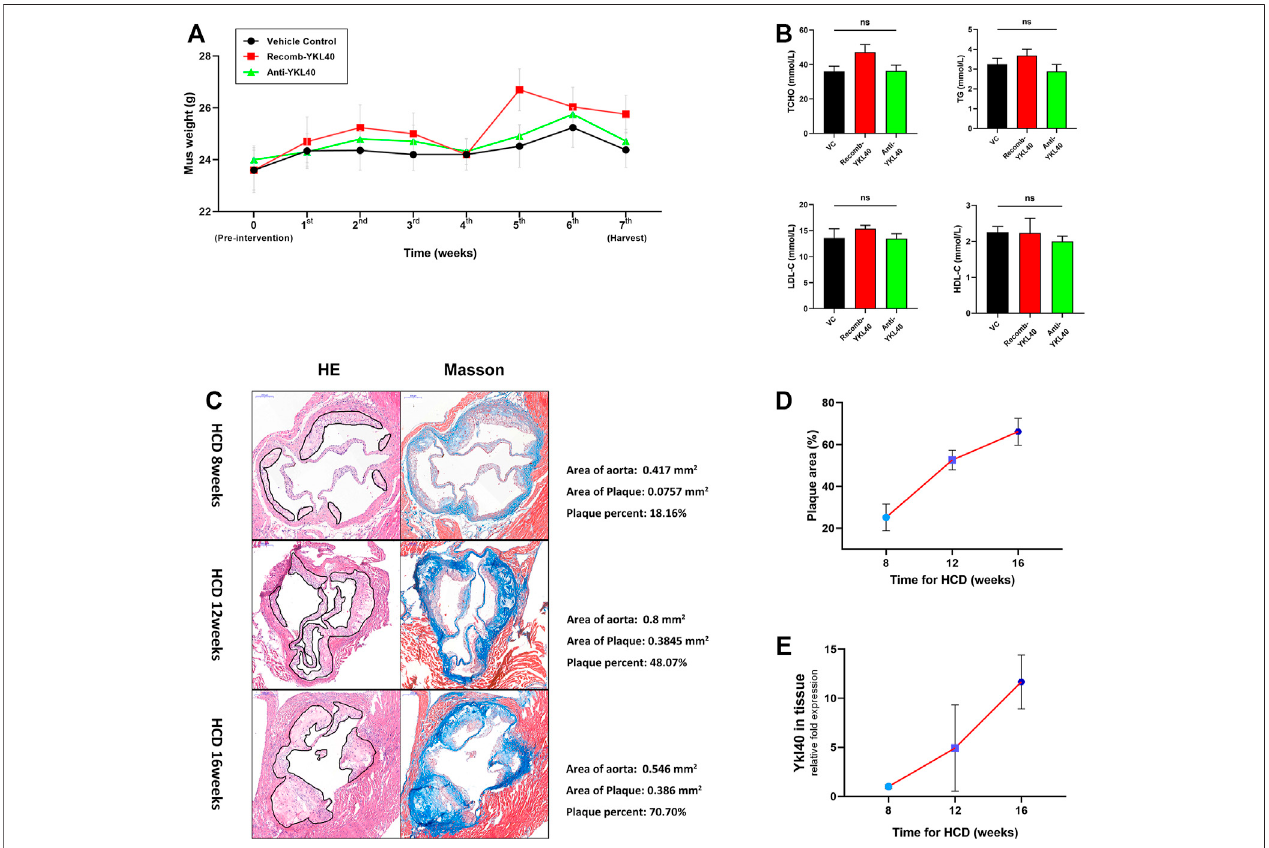
FIGURE 3 | (A) Weight curve of mice in different groups during intervention. No statistical differences were con fi rmed. (B) Blood lipid (TCHO, TG, LDL-c, HDL-c) levels of mice in different groups. No statistical differences were con fi rmed. (C) H&E and Masson staining on aortic valves of mice at 8, 12, and 16 weeks (the area of plaque is indicted by black lines). Calculations of the relative area are shown on the right side. (D) Increasing trend of aortic root plaque relative area as modeling time advanced. (E) Increasing trend of Ykl-l40 expression level on the aortic arch as modeling time increased.